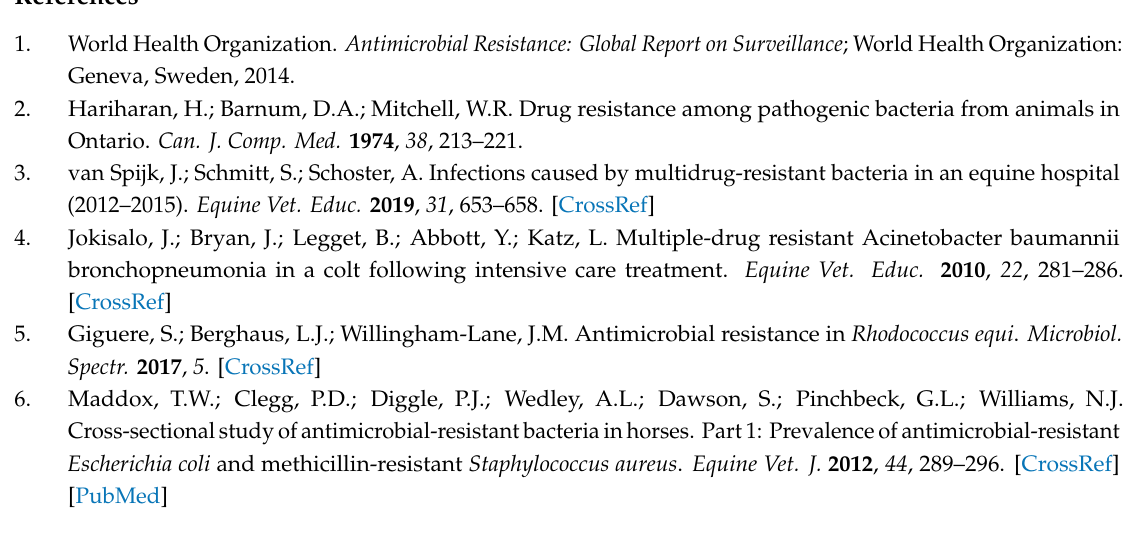
Figure S1: Questionnaire in French, Figure S2: Questionnaire in